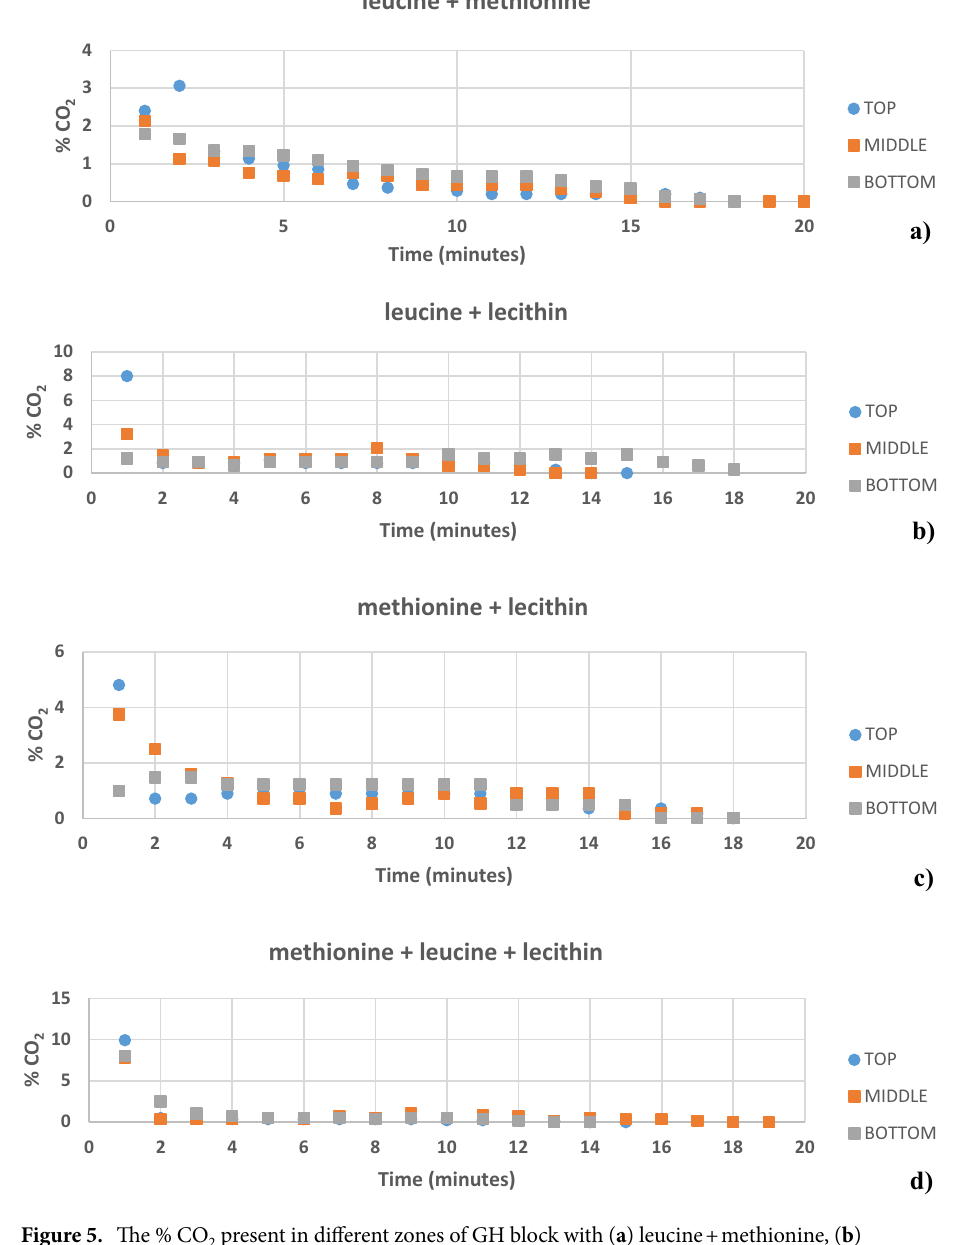
Figure 5. The % CO 2 present in different zones of GH block with ( a ) leucine + methionine, ( b ) leucine + lecithin, ( c ) methionine + lecithin, and ( d ) methionine + leucine + lecithin as